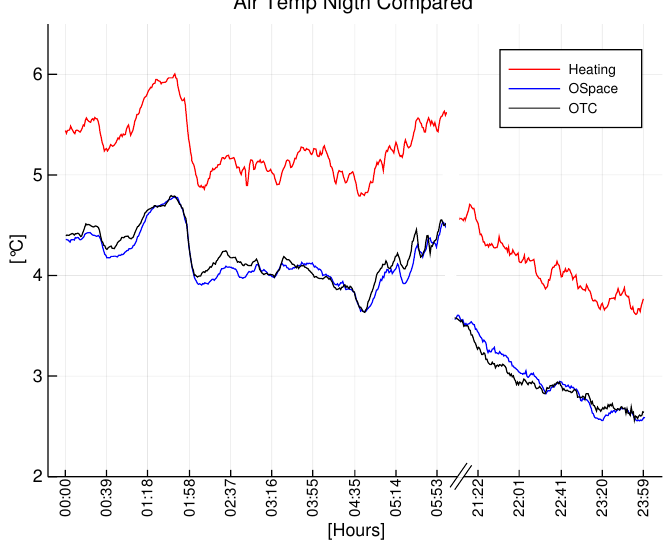
Figure 10. Nighttime temperature at nodes of each